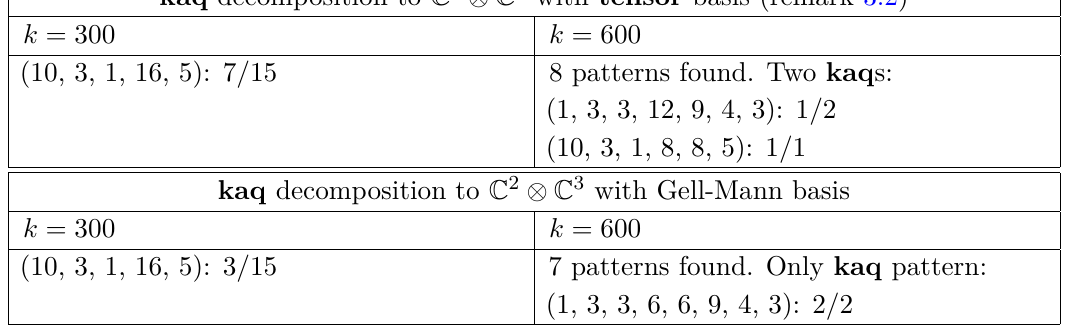
Table 10 . Kaq ness for L 26 on su (6) . To be compared with table 5.